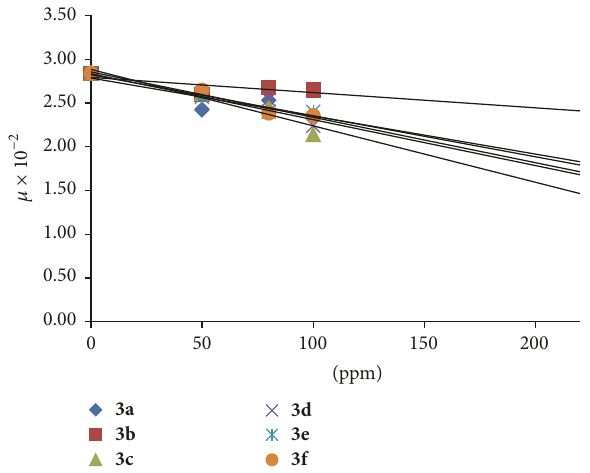
Figure 1: MIC graph for 3a – f